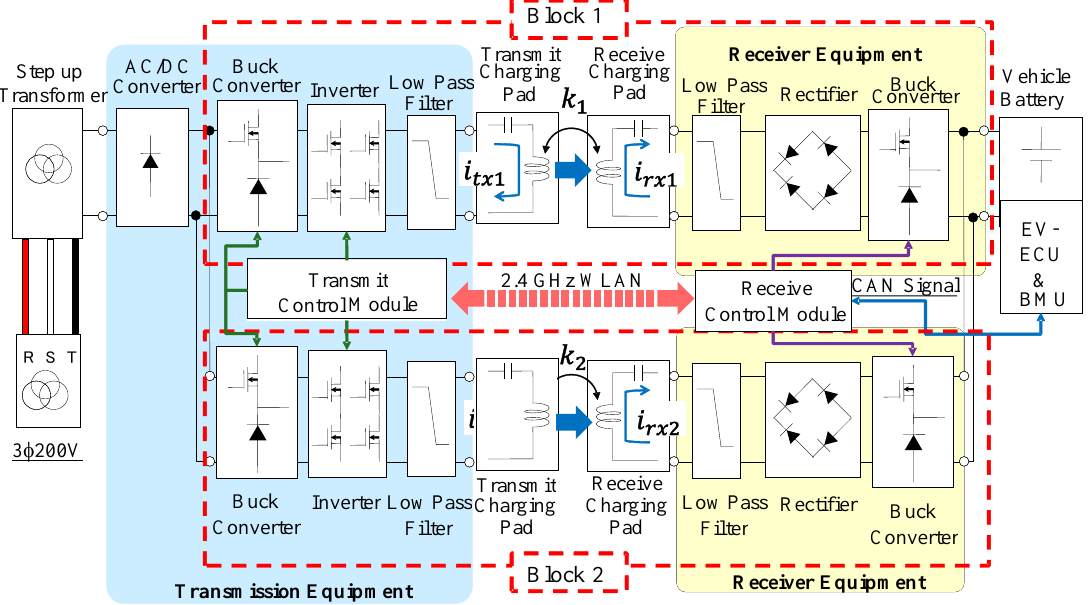
Figure 1. Block diagram of dual-block 44 kW wireless rapid charging system.